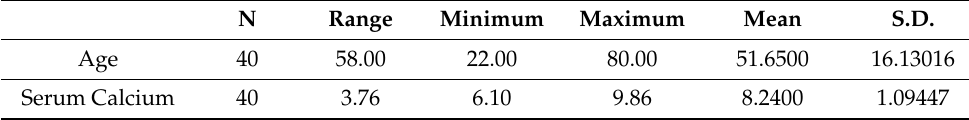
Figure 1. The relationship between gender and calcium level. Table 2. Descriptive statistics according to age and serum